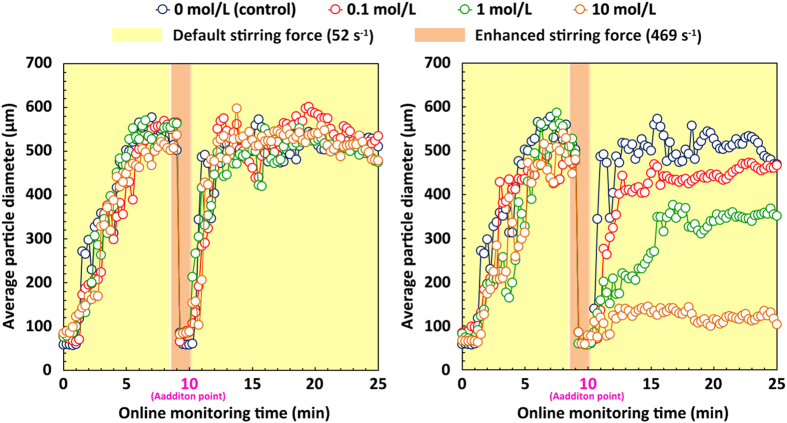
Effects of inter-particle forces on sludge aggregation.(a) Ethylene diamine tetraacetate (EDTA) was added at 4 different doses to 4 ideal reactors for 15 min to explore the potential role of ionic interactions in sludge aggregation. (b) Urea was added at varying doses to 4 additional reactors for 15 min to test the potential link between hydrogen bonds and sludge aggregation.